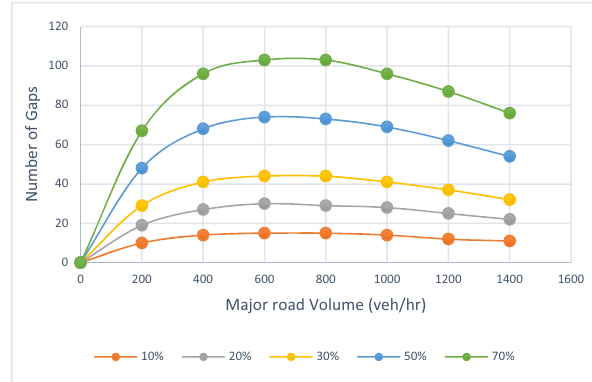
Figure 1: Number of usable gaps CAVs may possibly help create for right turns.